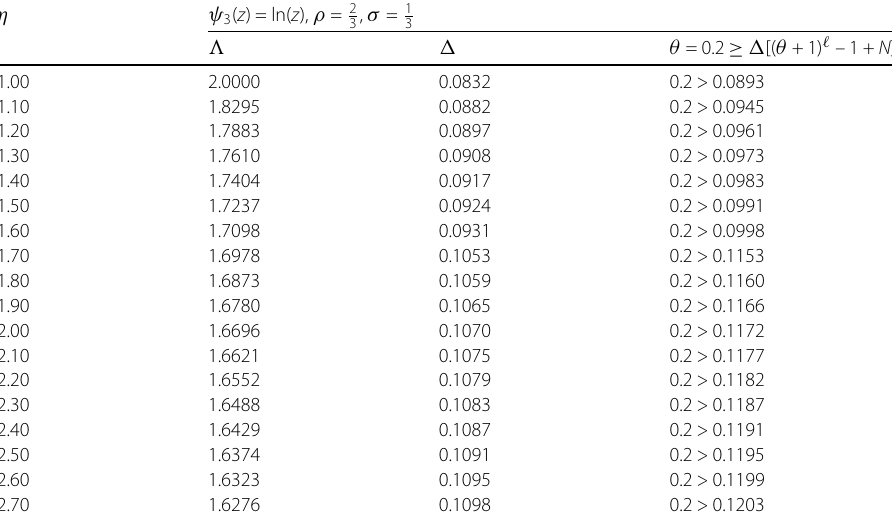
Table 3 Numerical results of (cid:27) and θ for ψ 3 ( z ) = ln( z ) and η ∈ J = [1, e ] in Example 5.1 η